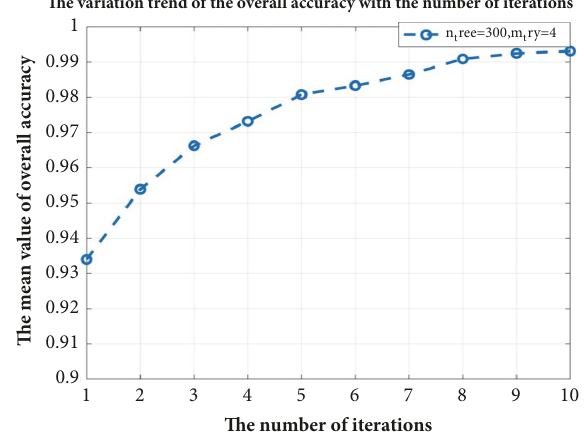
Figure 26: Classification accuracy trend of different initial and iterative condition of AVIRIS data for method 2.